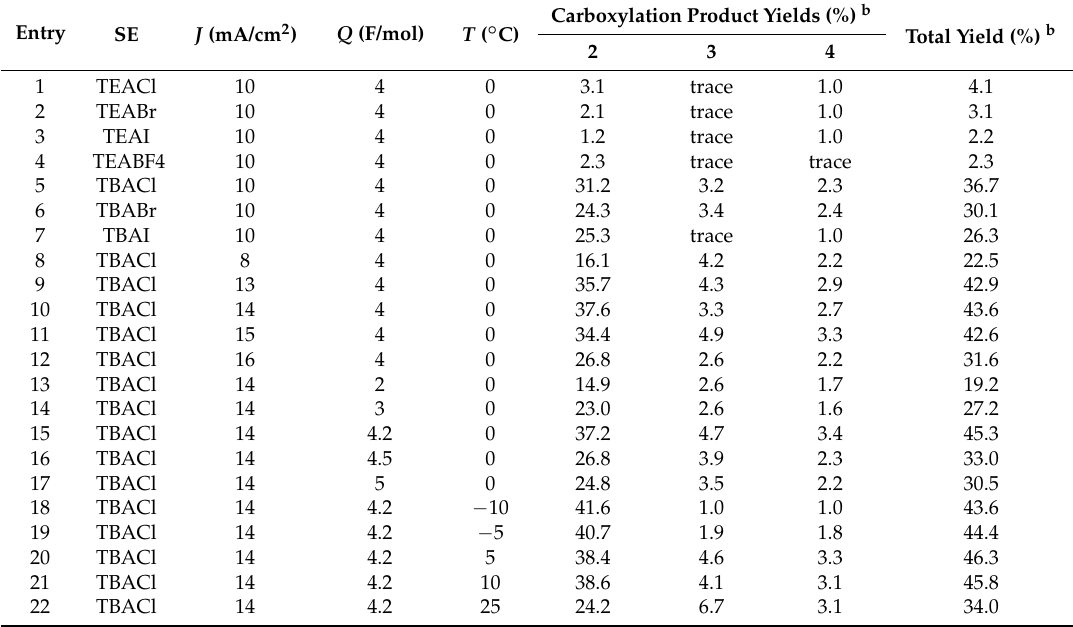
Table 1. Electrocarboxylation of 1,4-dichlorobenzene under various synthetic parameters a